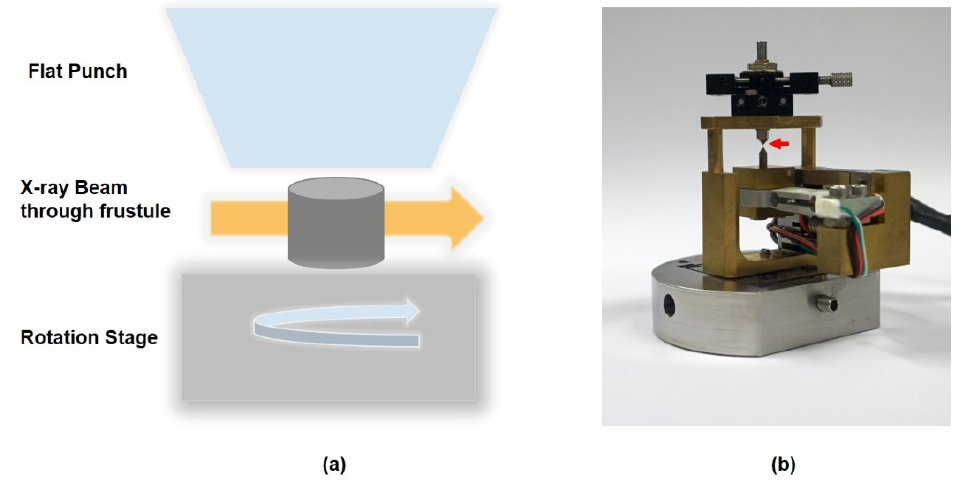
Figure 5. In situ compression test in nano-XCT. ( a ) Schematic diagram of the compression loading on the frustule inside the nano-XCT system and ( b ) photo of the compression loading sample stage, red arrow: pin with sample.